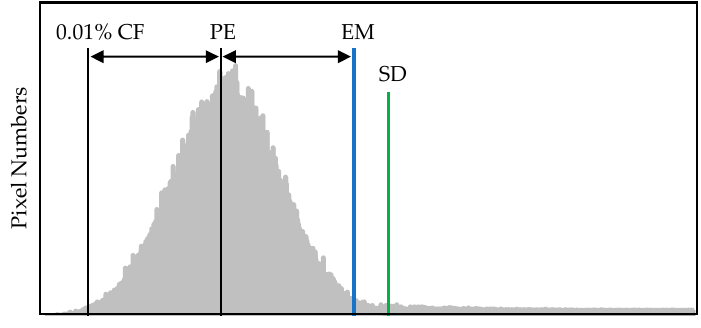
Figure 7. Visualization of floating macroalgae detection from frequency distribution via exclusion method [15–17] and standard deviation method. CF, cumulative frequency; PE, nearest peak; EM, exclusion method; SD, standard deviation method. The details of these methods are found in the main text.